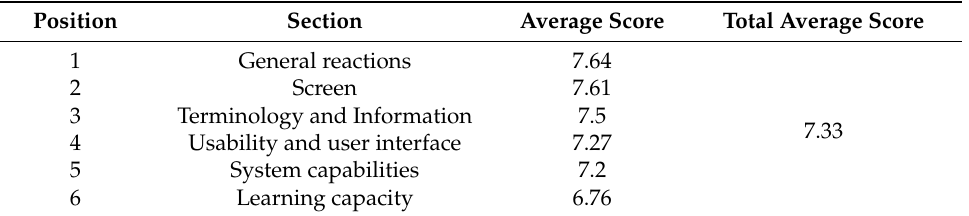
Table 7. Results of Instrument 2, patient profile.